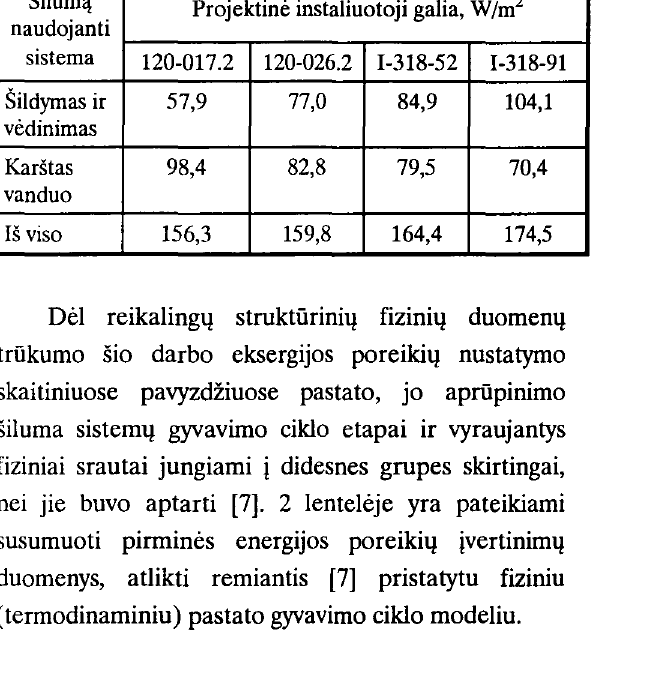
Table 2. Primary energy ( aprox. eqv. exergy) demands at different stages of building life cycle for dwelling houses Zy- Pasta